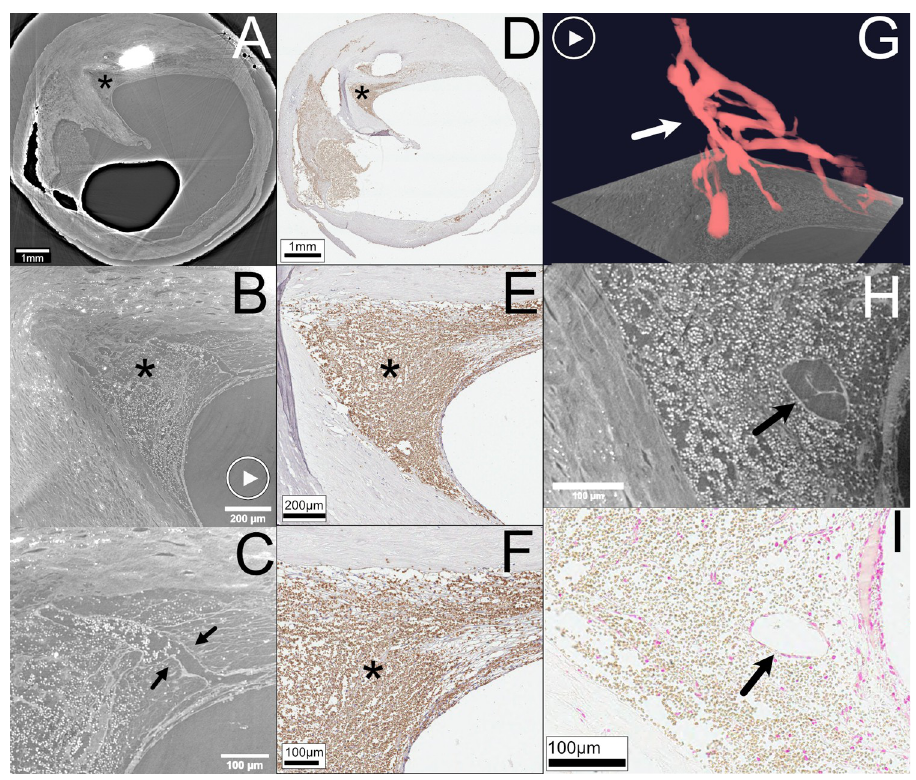
thrombus is seen zoomed-in with HR SR μ CT with the neo-vessels indicated with black arrows in (C) . The corresponding histologic section stained for erythrocytes (Glycophorin A) is seen in (D) . In (E) and (F) , the thrombus area is magnified and marked with a black asterisk. (G) depicts a 3D reconstruction of the neo-vessels highlighted with red (arrow). In (H) a detailed area in the organized thrombus seen with HR SR μ CT is shown with the black arrow indicating one of the neo-vessels with a matching location on a histological section (Von Kossa staining) seen in (I) , where the black arrow indicates the neo-vessel. The "play" symbols in (B) and (G) : movie material available online, showing the HR tomographic image stacks (S6 Movie in S1 File) and the 3D render of the segmented and highlighted neo-vessels (S7 Movie in S1 File), respectively. Plaque ID 1 in S1 Table in S1